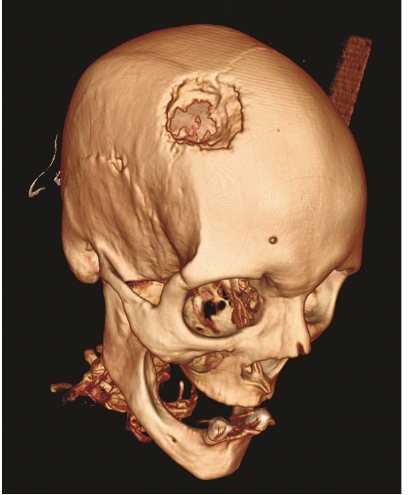
Figure 2: View of the mass in 3D computerized